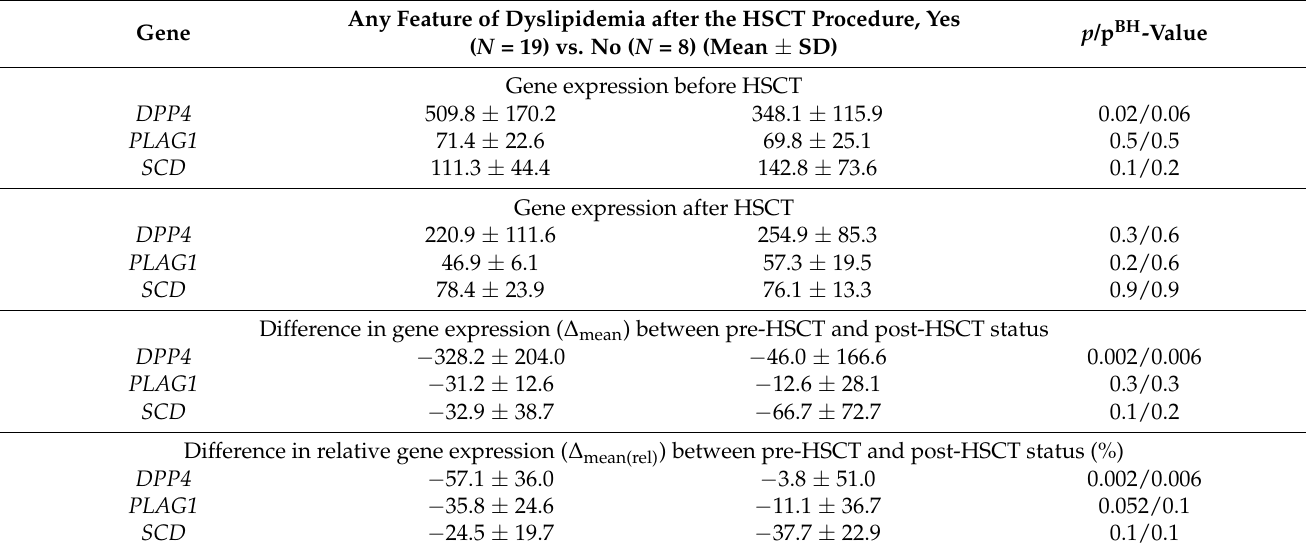
Table 8. Expression of genes associated with lipid metabolism in children who presented any feature vs. no feature of dyslipidemia after